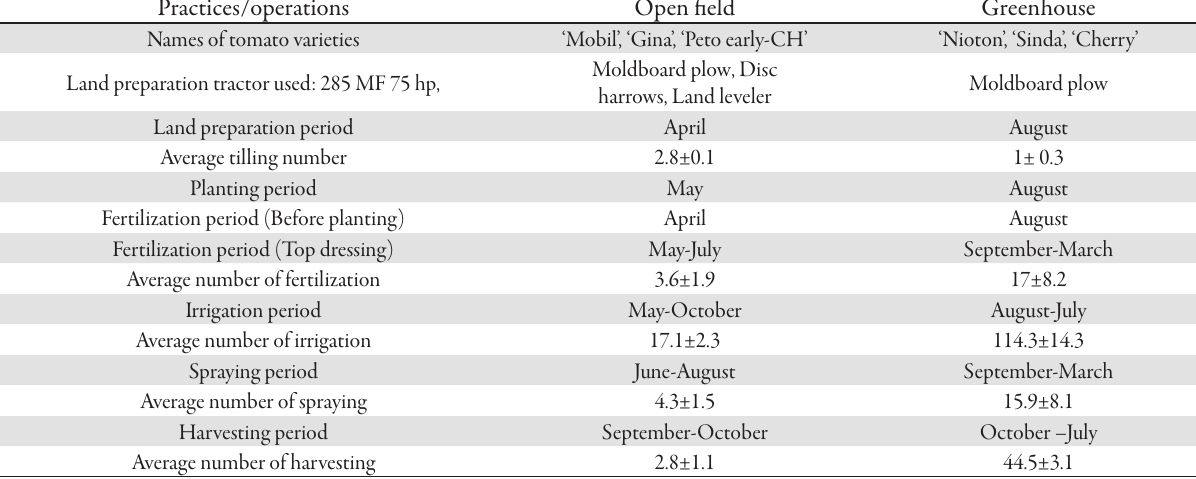
Tab. 2. Management practices for open field and greenhouse tomato production